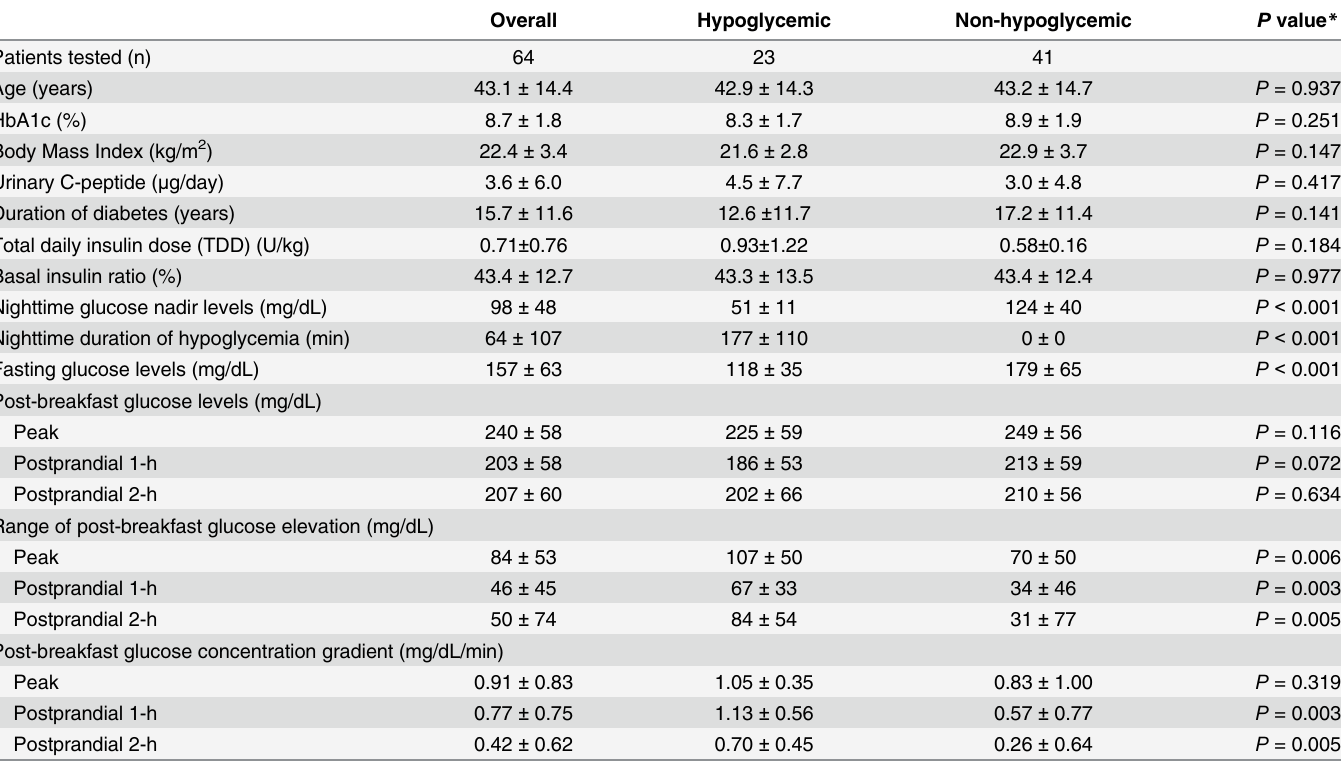
Table 1. Patient Profile and Parameters for Glycemic Variability Compared between Hypoglycemic and Non-hypoglycemic